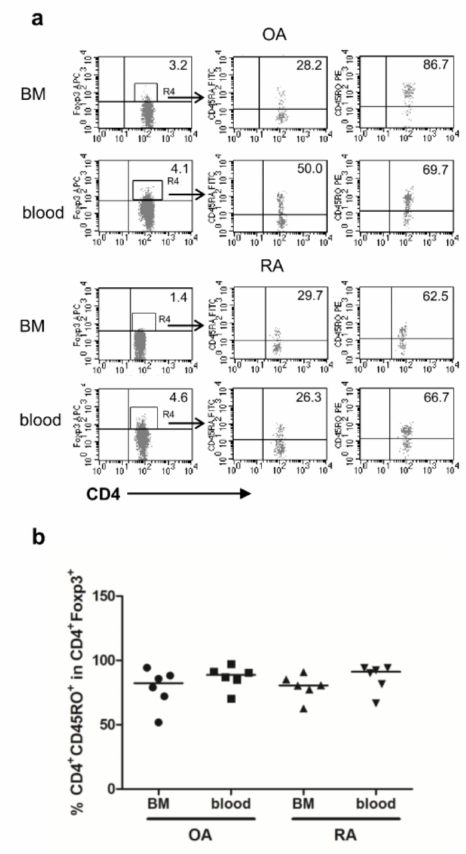
Figure 5. CD45RO expression by gated CD4 + FOXP3 + cells in the BM and peripheral blood of OA and RA patients. ( a ) Representative dot plots show CD45RA and CD45RO staining of CD4 + FOXP3 + cells from the BM and peripheral blood from the same patient. ( b ) Expression of CD45RO by CD4 + FOXP3 + Tregs from the BM and peripheral blood from OA and RA patients. Individual results are shown as dots and median as a bar on charts ( n = 6 subjects per group). OA / RA BM / blood—cells isolated from the BM / peripheral blood of patients with OA / RA,